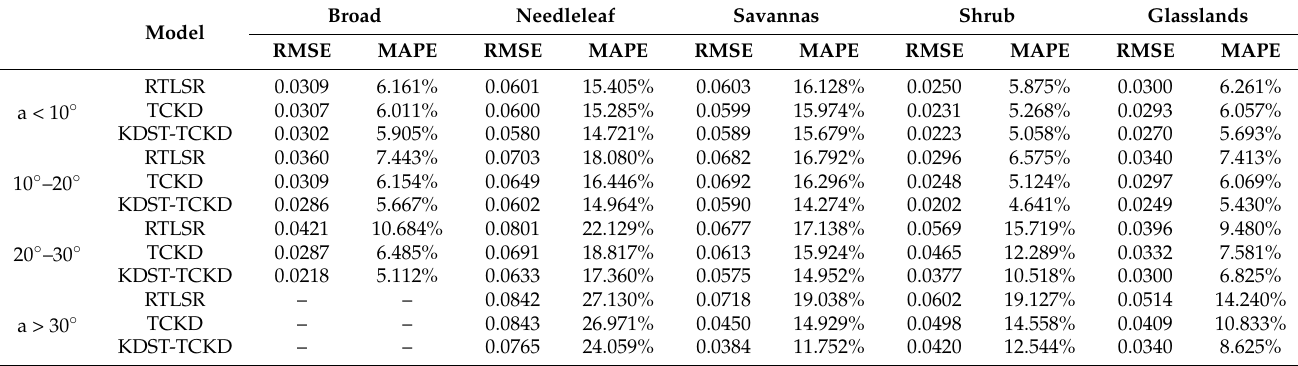
Table 3. Comparisons of the retrieval accuracy of RTLSR model, TCKD model, and KDST-TCKD model in the NIR band under different land-cover types and different α .